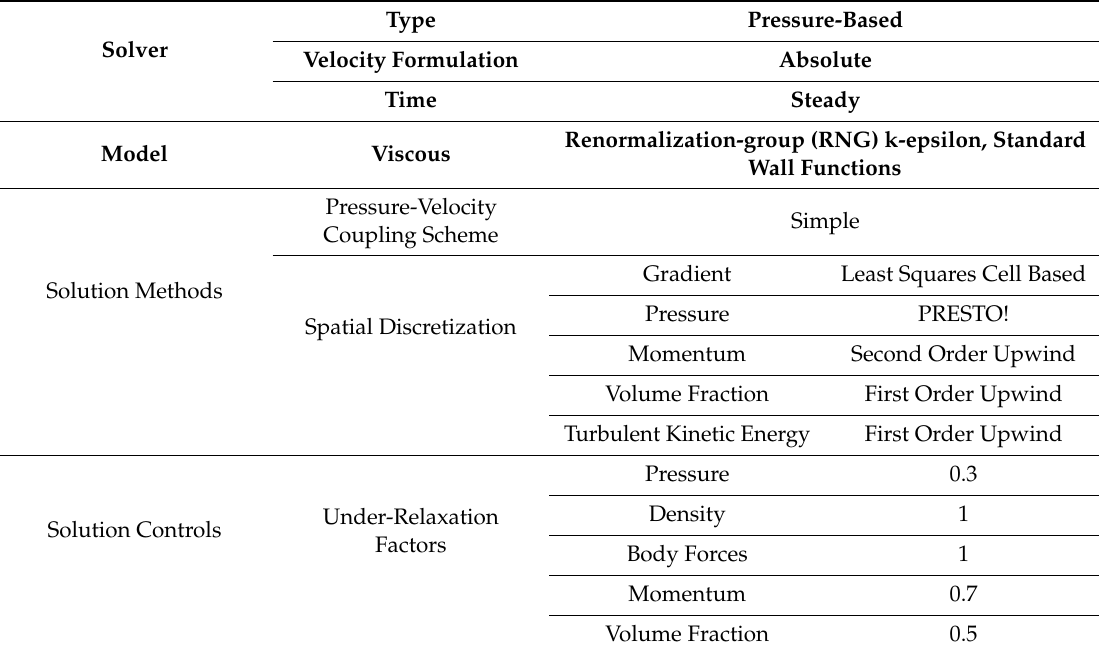
Table 1. Settings of computational fluid dynamics (CFD) analysis.